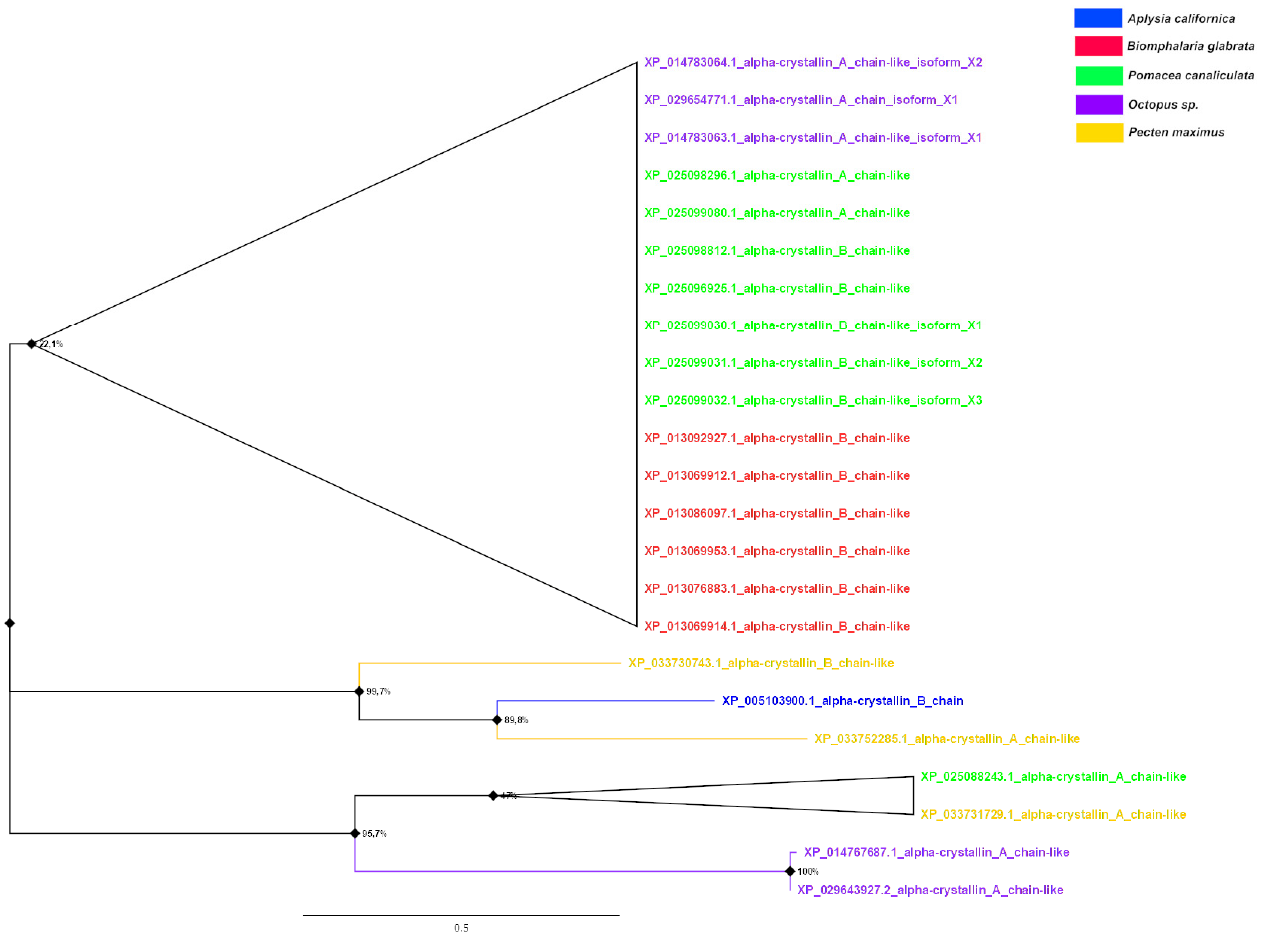
Figure 5. Phylogenetic tree of α -crystallins of